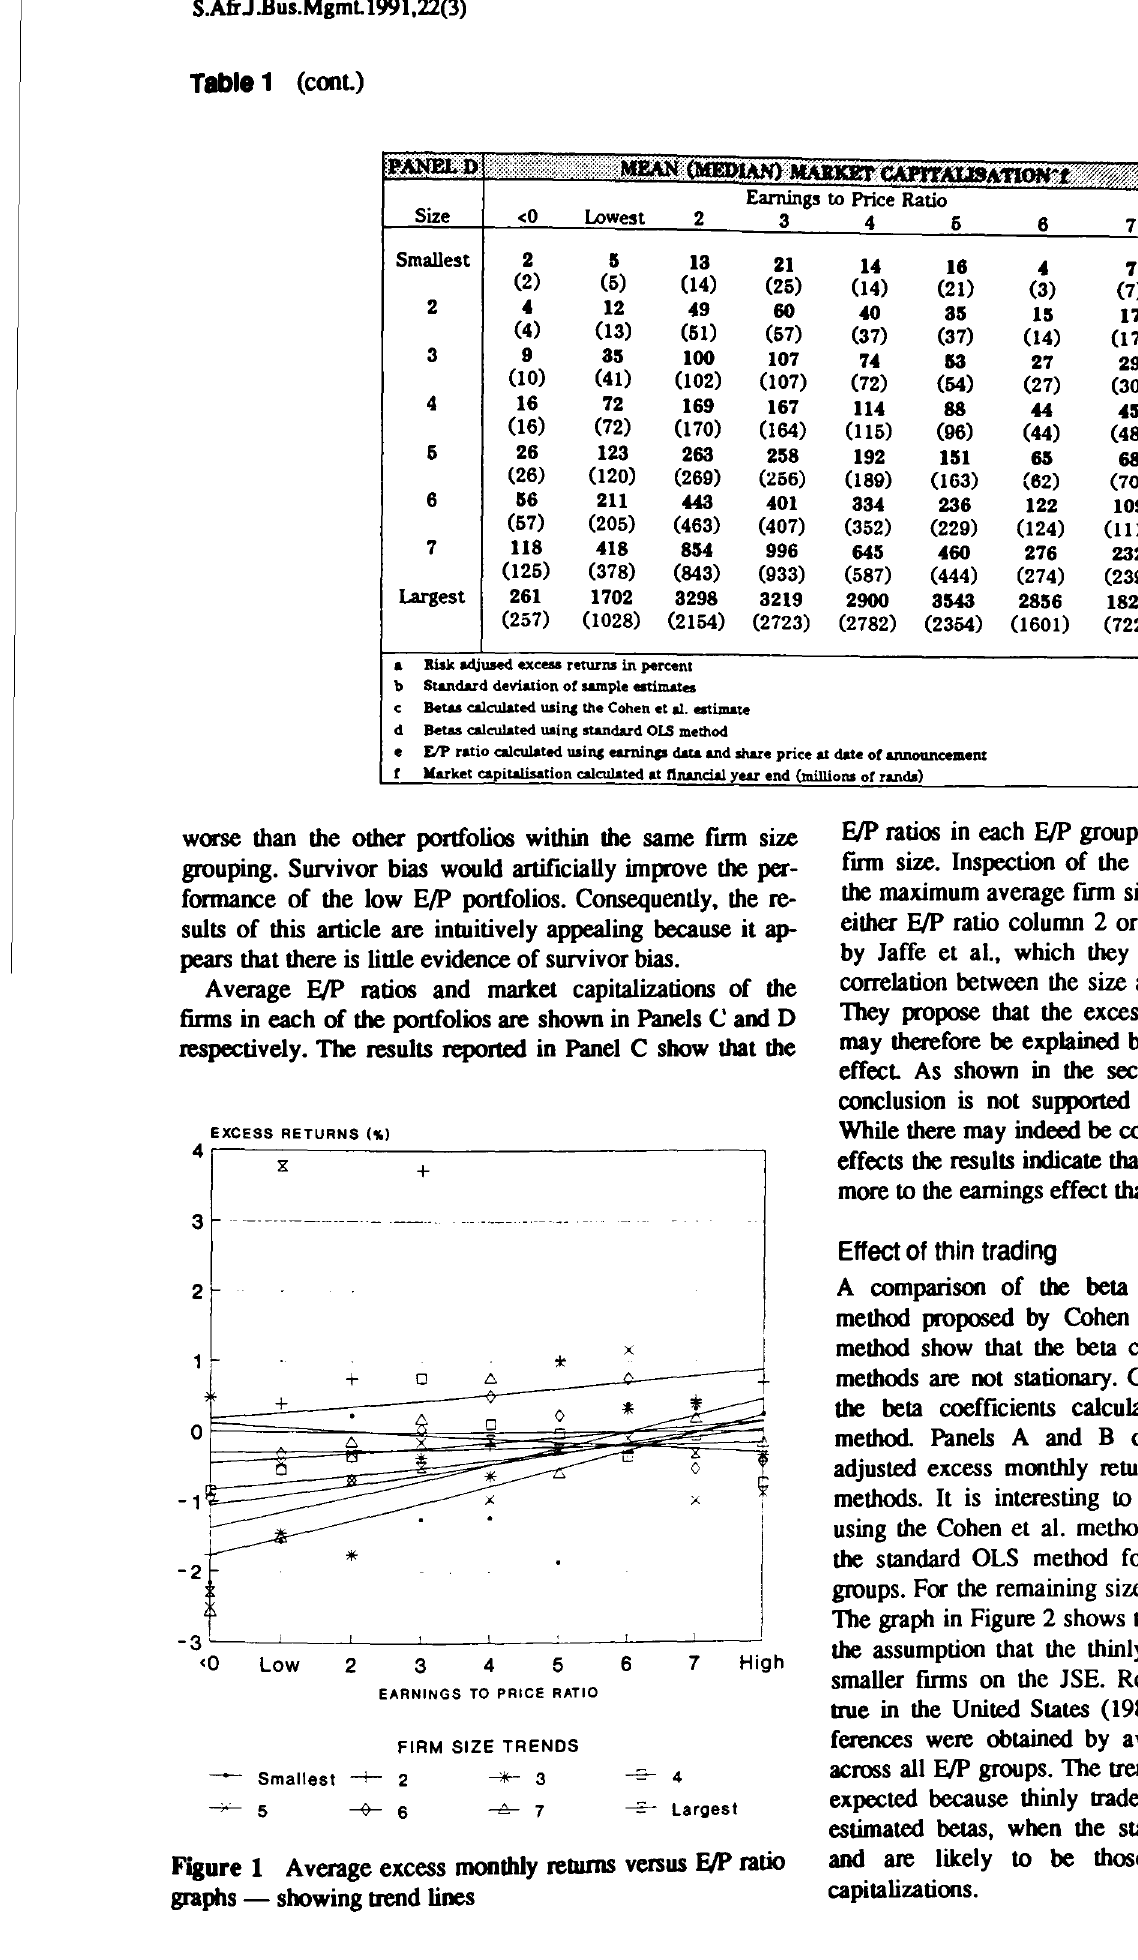
Figure 1 Average excess monthly returns versus FJP ratio graphs - showing trend